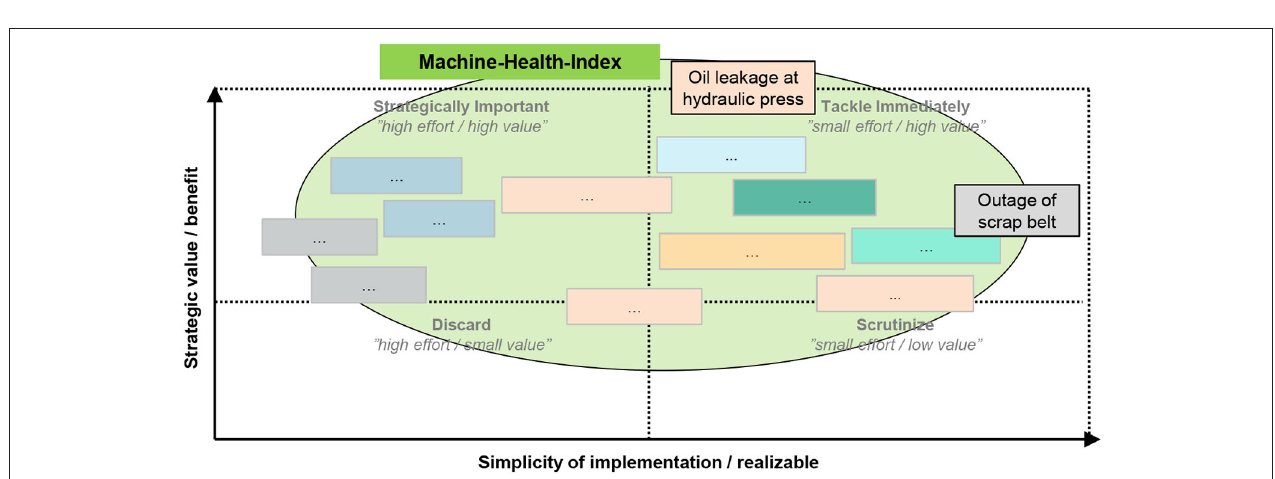
FIGURE 5 | Selection of Use Cases with a portfolio. Colored boxes represent Use Cases (partly anonymized), where similar colors represent logic groups of Use Cases. Additionally, clusters can be found (e.g., all Use Cases contribute to “Machine-Health-index,” marked green). The two example Use Cases “oil leakage at hydraulic press” and “outage of scrap belt” are located in the upper right quadrant, thus being most simple to implement, yet yielding most